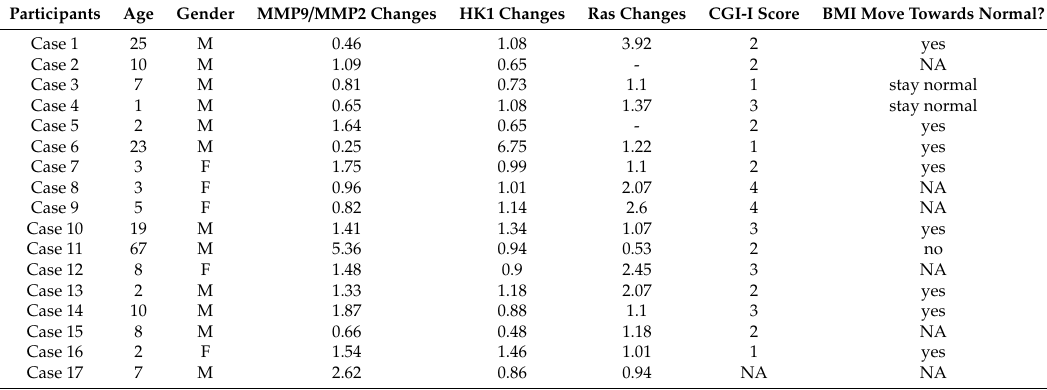
Table 2. Patient molecular barcode representing change in MMP9, HK1, and Ras plasma expression levels; clinical measures including CGI-I post treatment; and change in BMI post metformin treatment relative to each patient’s own baseline. Blood samples for each participant before and after metformin treatment were processed within 2 h of collection time for plasma isolation. MMP9 expression was measured by Luminex xMAP technology. Ras and HK1 expression levels were measured by Western blot. Cut-o ff ± 5% was used; increased expression was > 5%, decreased expression was <